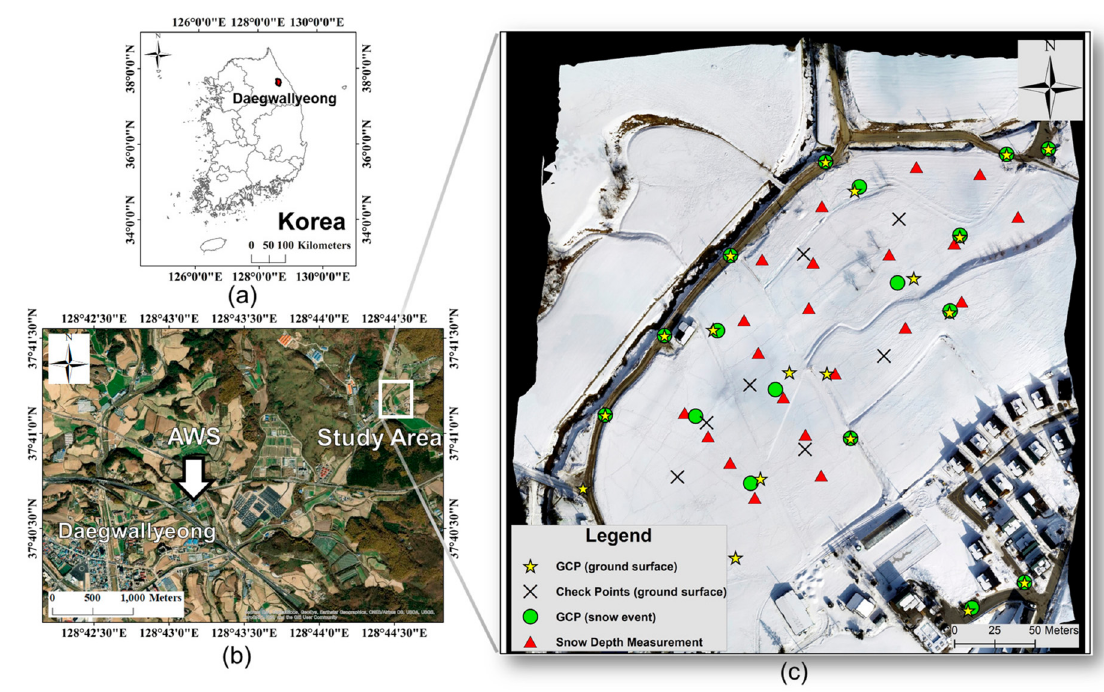
Figure 1. Study area: ( a ) Location of Daegwallyeong-Myeon; ( b ) Location of Automatic Weather Station (AWS) and study area; ( c ) Aerial photo of the study site. Yellow stars and X marks represent GCPs and check points on the ground surface, respectively. Green circles and red triangles represent GCPs and the in situ snow depth measurement location on the snow surface, respectively.